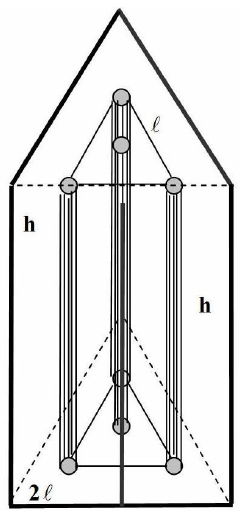
Figure 2. Triangular prismatic representative volume element (RVE).